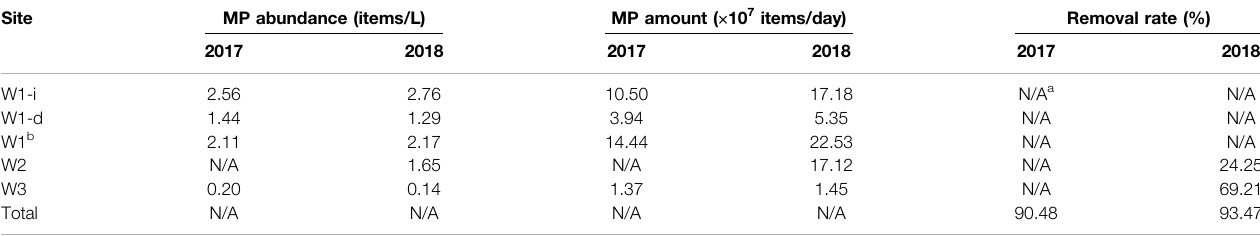
TABLE 2 | MP abundance and removal rate at various sampling sites on the sampling day. Site MP abundance (items/L) MP amount ( × 10 7 items/day)